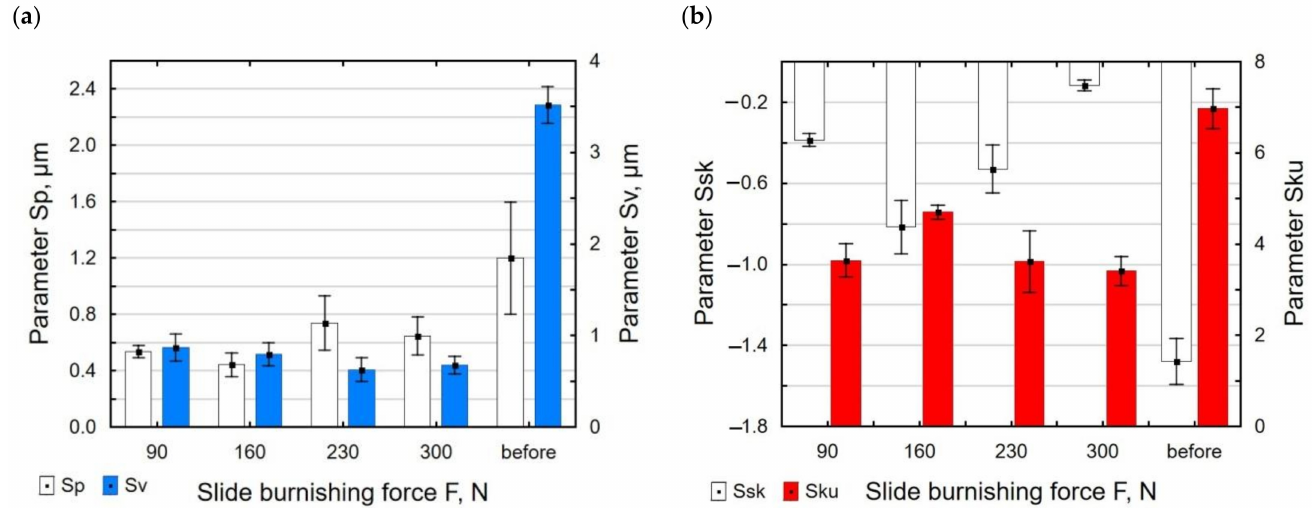
Figure 11. Burnishing force versus surface roughness parameters: Sp and Sv ( a ); Ssk and Sku ( b ) ( f = const. = 0.06 mm/rev., v n = 35 m/min, i = 1).